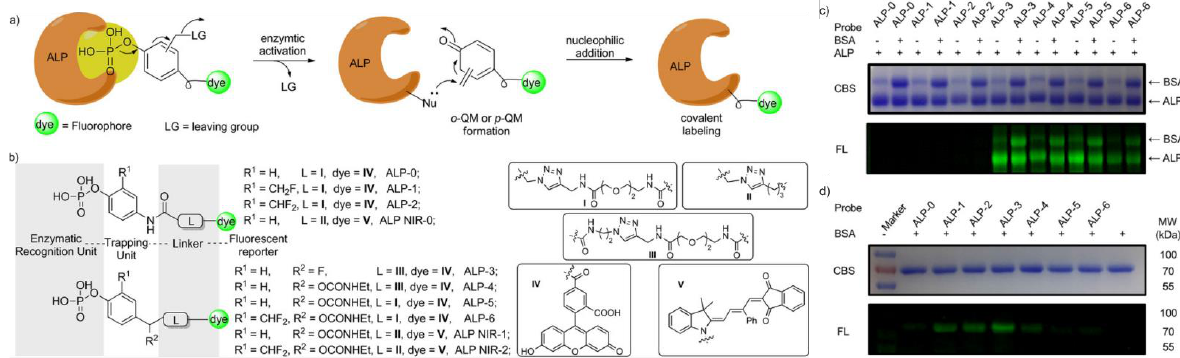
Figure 5. ( a ) Ligation mechanism of alkaline phosphatase activity-based probes and ( b ) the structure of the synthesized ALP and ALP-NIR probes. ( c ) Coomassie blue staining (CBS) and fluorescent (FL) imaging of ALP (12.5 U mL − 1 ) enzyme with the activity probes (7.5 µM, 1 h incubation) in the presence or absence of BSA (0.15 mg mL − 1 ) at 37 °C. ( d ) Imaging of BSA with the probes (7.5 µM, 1 h incubation) in the absence of ALP enzyme at 37 °C. Reproduced with permission from [37], copyright 2019 John Wiley and Sons . Table 2. Non-fluorogenic activity-based probes for different phosphatases.